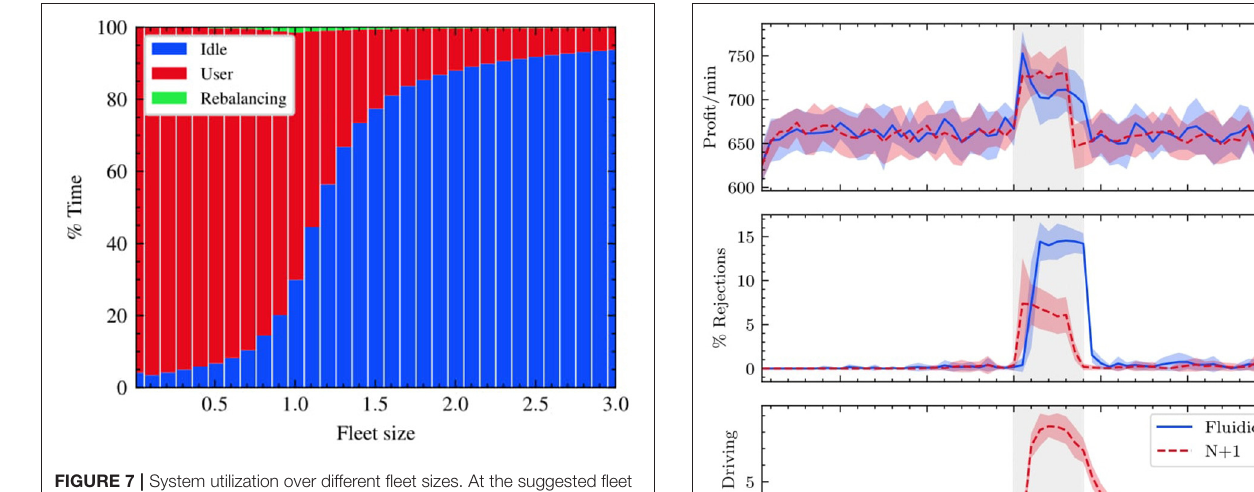
FIGURE 7 | System utilization over different fleet sizes. At the suggested fleet size, corresponding to γ = 1.0, we observe that vehicle utilization is around 70% compared to 5% for private vehicles.